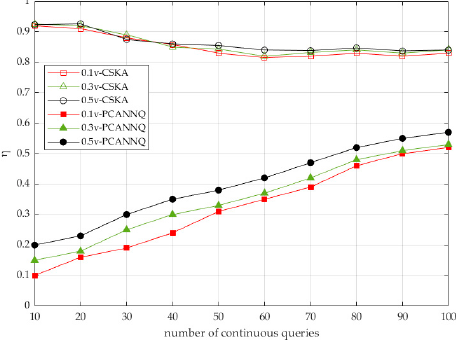
Figure 12. Security of trajectories.